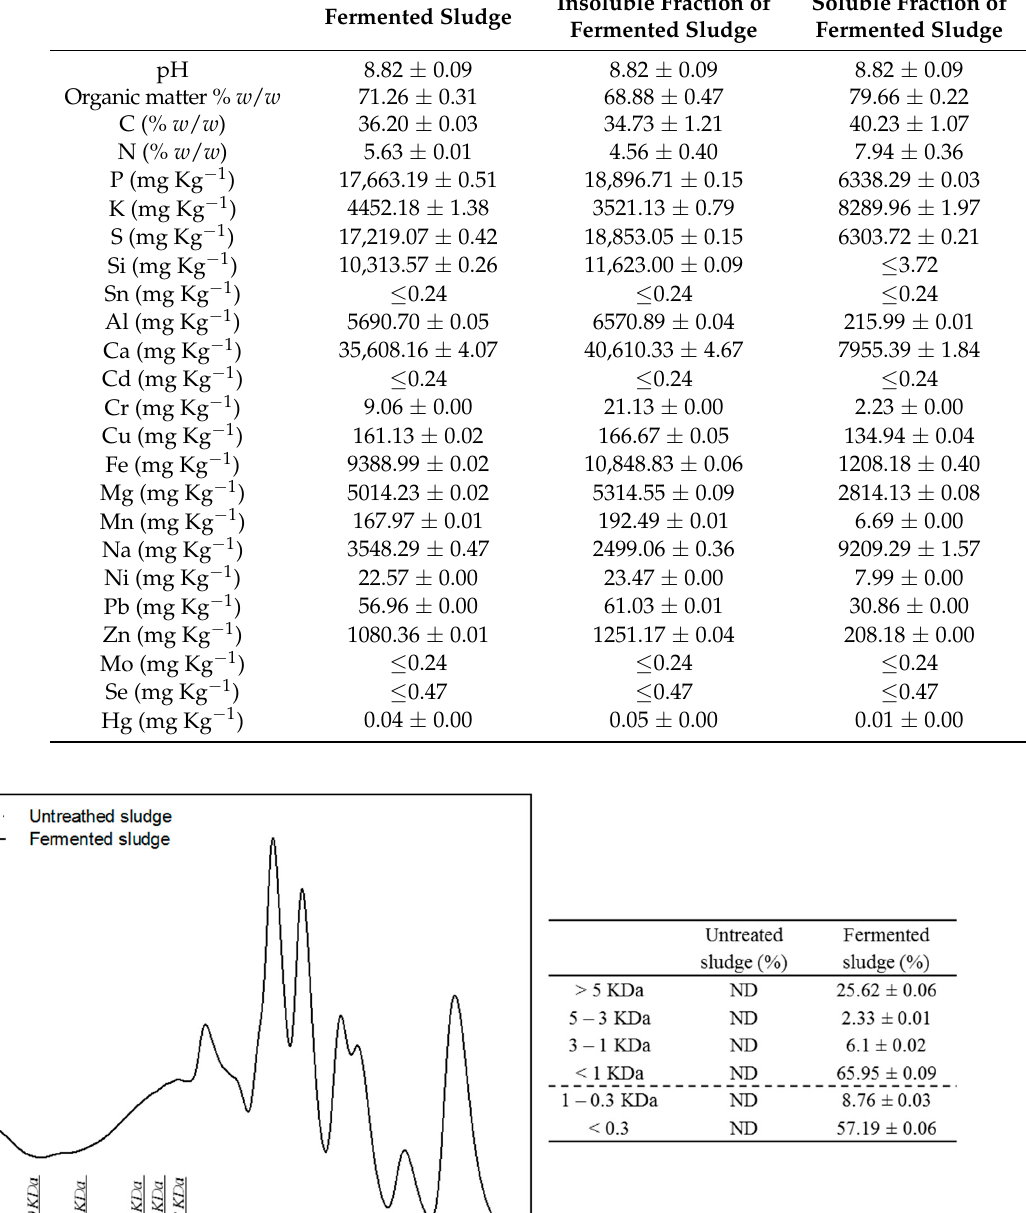
Table 1. The chemical characterization of the soluble organic component of the different ferment-